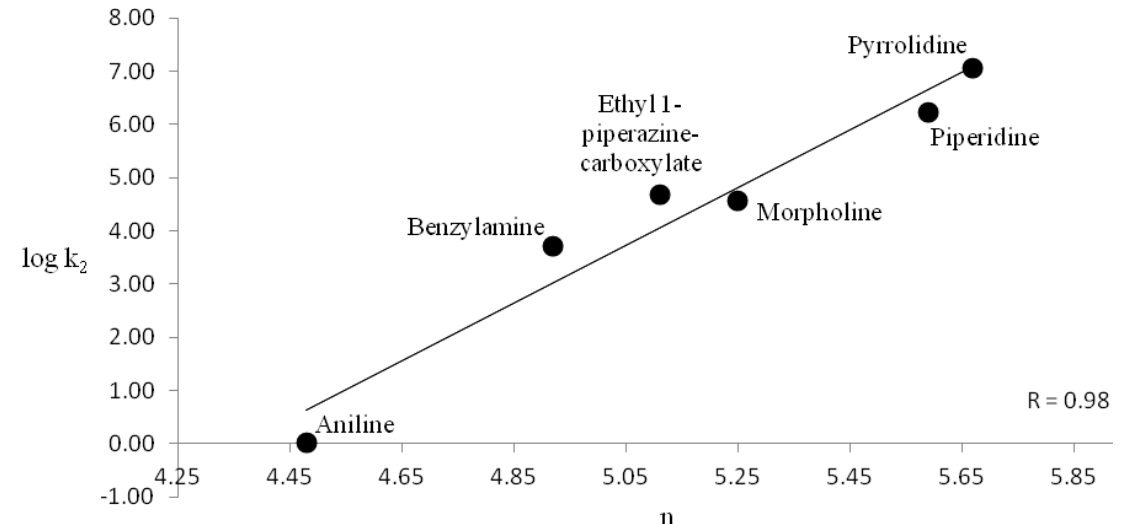
Figure 3. Swain-Scott nucleophilicity n vs. log k